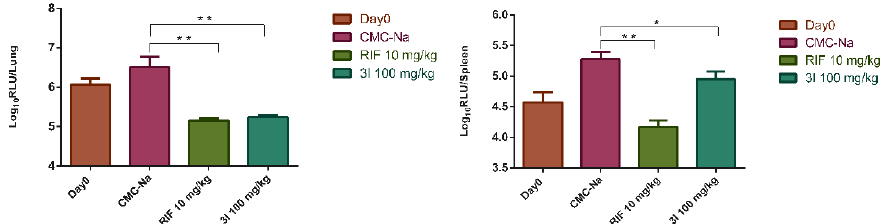
Figure 1. In vivo inhibitory activity of 3l on a mouse model infected with Mtb H37Ra. Four mice per group were treated for 6 days. Data were presented as mean ± SD. * , p < 0.05; ** , p < 0.001.